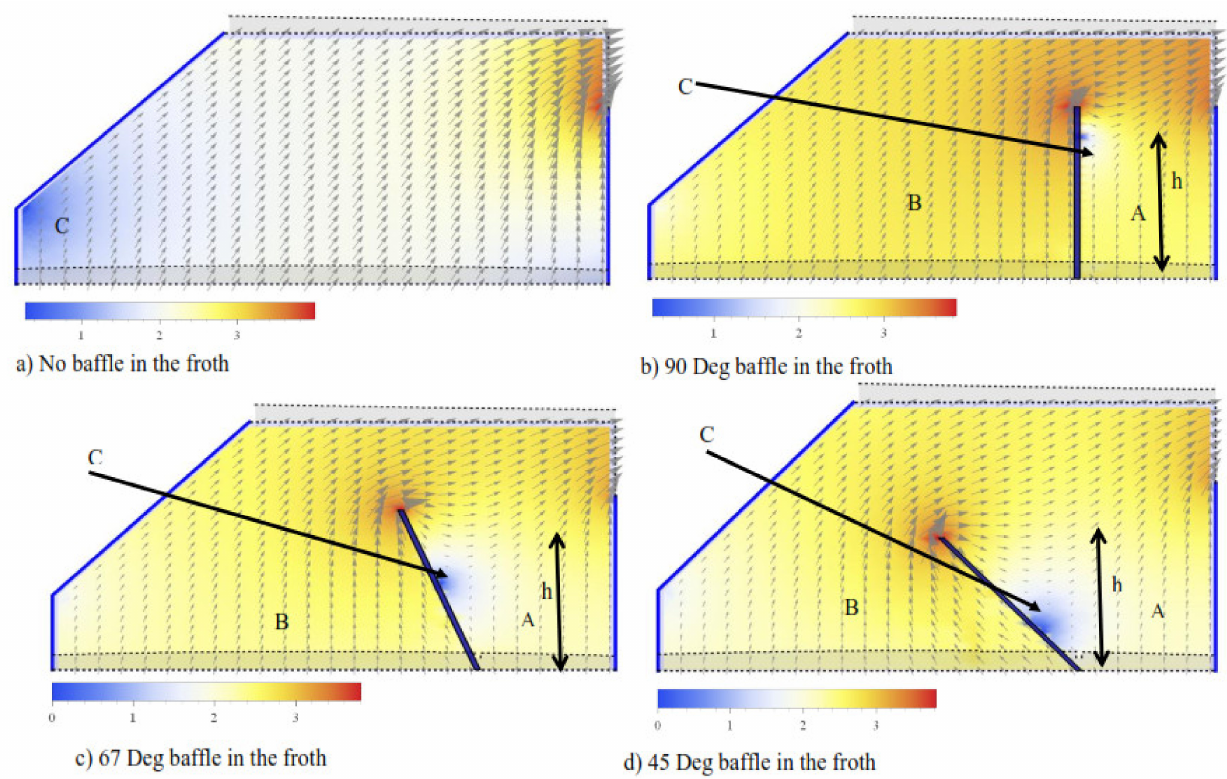
Figure 20. Froth zone velocity distribution: ( a ) no baffle in the froth; ( b ) 90 ◦ baffle in the froth ( c ) 67 ◦ baffle in the froth; ( d ) 45 ◦ in the baffle; A, B, and C represent critical regions in the froth zone